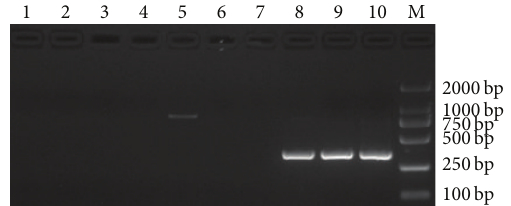
Figure 5: Sensitivity of the nested PCR assay. 1–5: the first PCR products; 6–10: the second PCR products. 1, 6: negative control; 2, 7: 10 −4 dilution;3,8:10 −3 dilution.4,9:10 −2 dilution;5,10:10 −1 dilution; M: DL2000 DNA